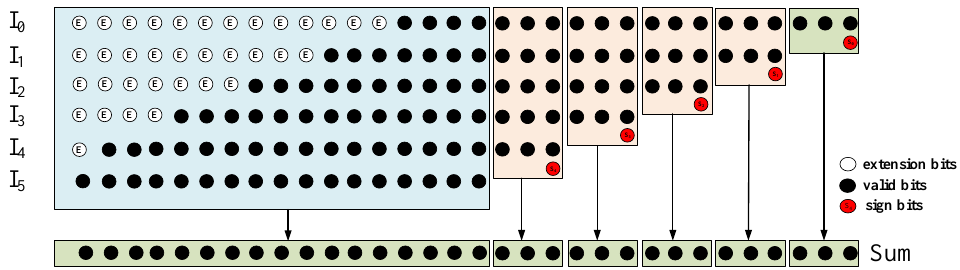
Figure 6. The PPA process of the sixteen 32-bit PPs.